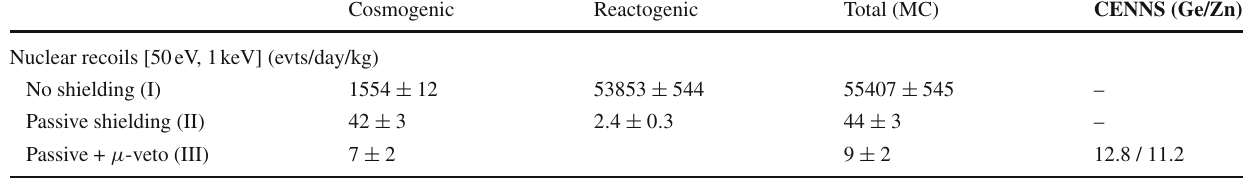
Fig. 9 Simulated energy experiment at ILL, 8.8 m away from the core of the 58.3 MWth nuclear reactor. The CENNS signal is given by the green distribution while the resulting nuclear recoil background from the cosmogenic and reactogenic components correspond respectively to the dark and light blue histograms. The presented background simulation results correspond to the shielding configuration (III), see Table